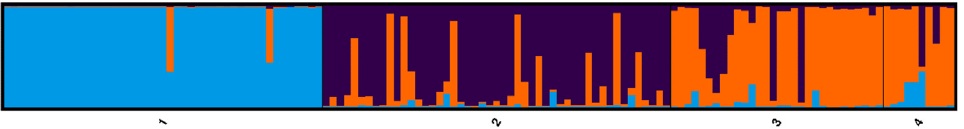
Figure 3. Inferred ancestry for K = 3 genetic cluster using STRUCTURE analyses. The blue cluster (1) includes the National Champion tree and its progeny. The purple cluster (2) is the Ohio